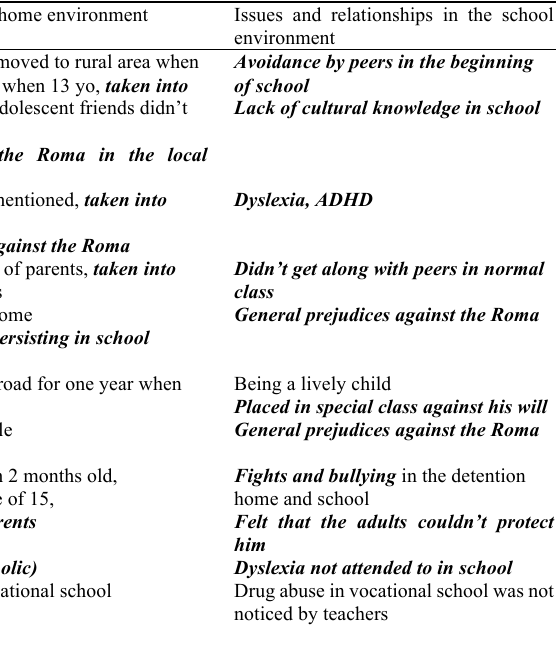
Presentation of time, school arrangements and social relations of the participants’ school years. Elements indicating fragility in perceived physical and/or psychological safety marked with bold